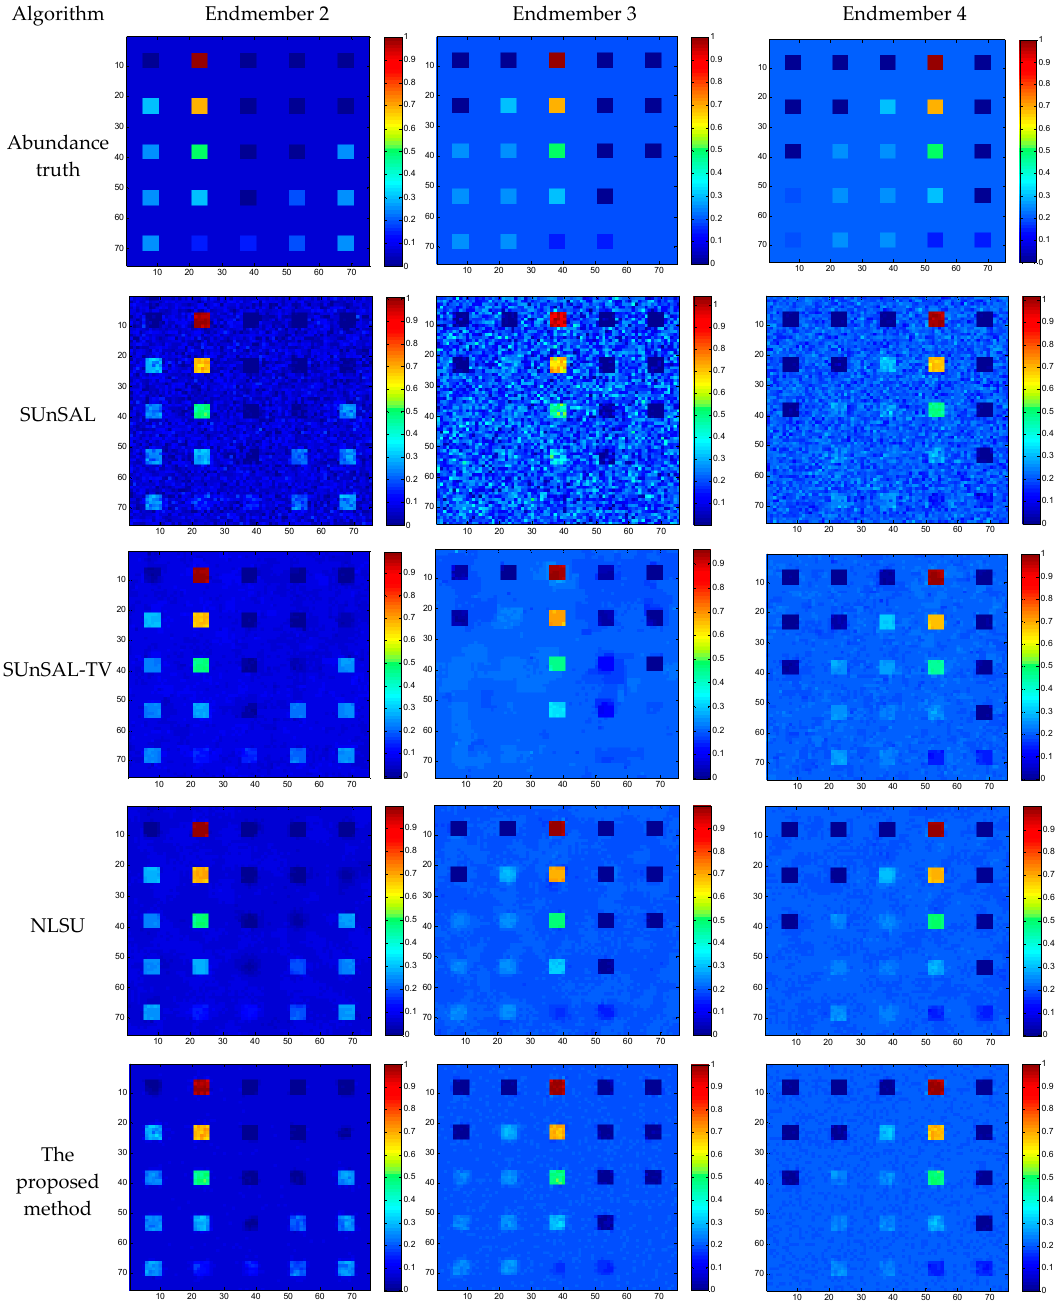
Figure 6. Estimated abundances of endmembers for DC-1.